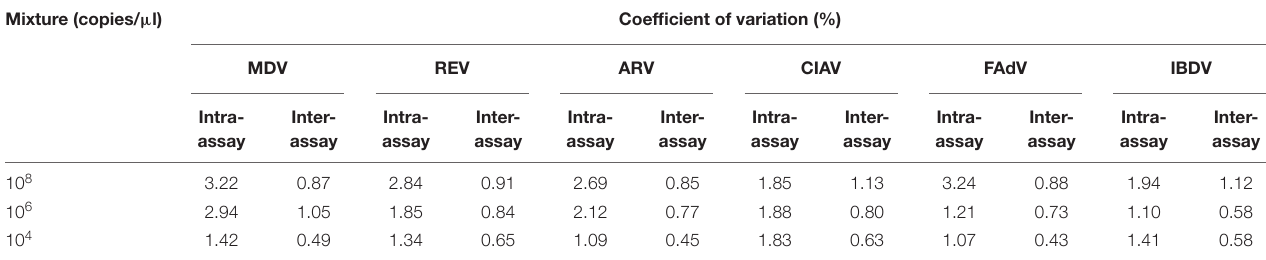
TABLE 4 | Intra-assay and inter-assay coefficient of variation. Mixture (copies/ µ l) Coefficient of variation (%)